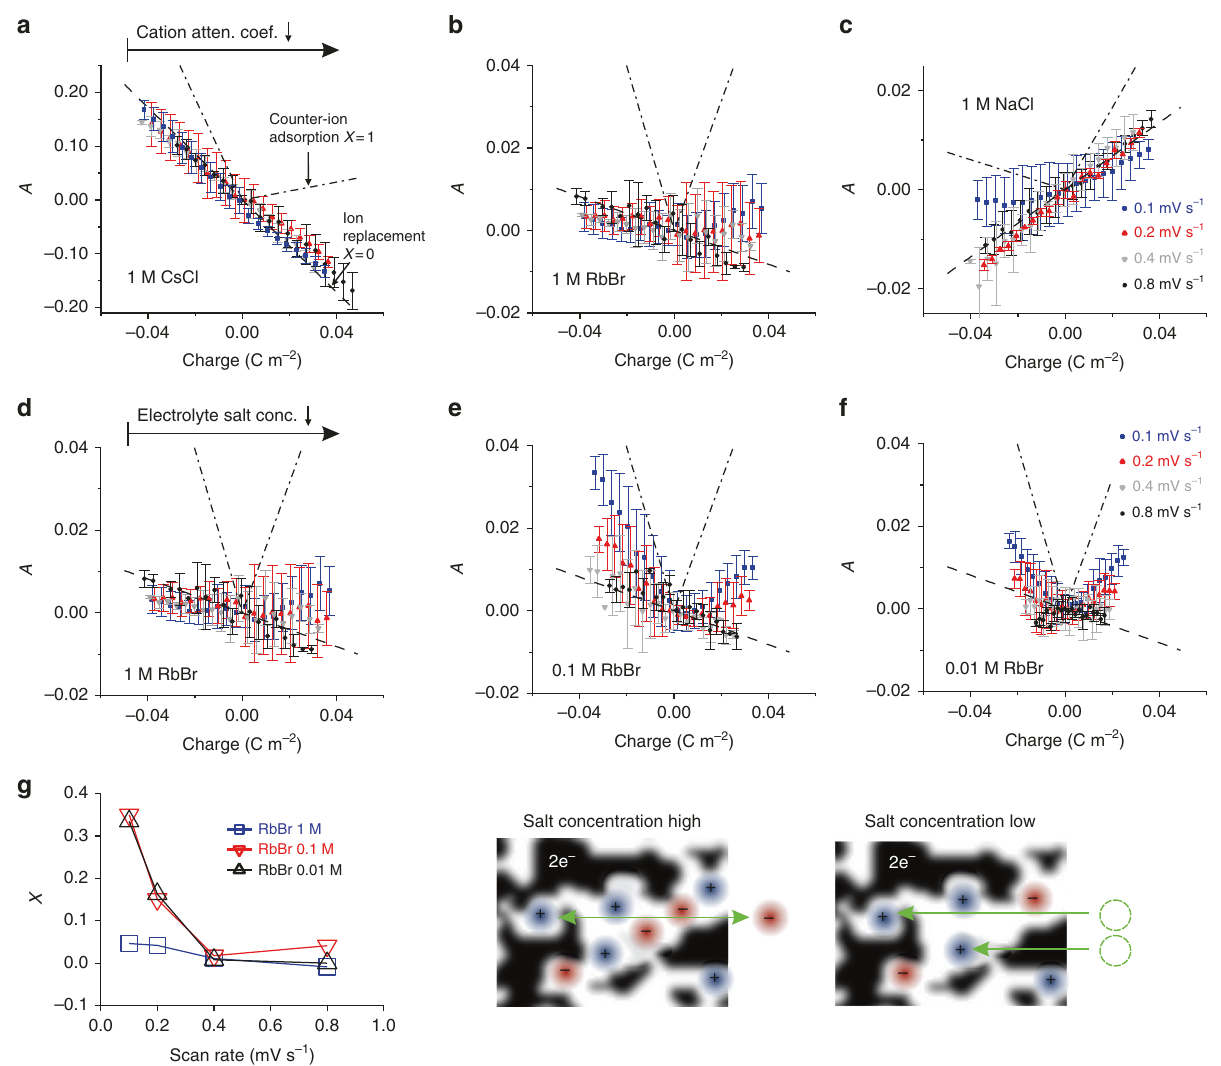
Fig. 2 Quanti fi cation of parameters controlling ion charge storage mechanisms. a – f Relative attenuation A (Eq. 2) vs. electrode charge for in situ cells using different aqueous electrolytes at four different scan rates with ±0.5 V maximum applied cell voltage. In a – c , the attenuation coef fi cient of cations (Table 1) becomes smaller from left to right, whereas in d – f , the salt concentration was decreased from left to right. The black lines indicate the theoretical attenuation curves for pure ion swapping (dashed) and counter-ion adsorption (dashed dotted) calculated from Eq. 2. Note the different scales in a – c . The charge storage mechanism is quanti fi ed in g plotting the charge storage parameter X (see Eq. 3) vs. the scan rate for RbBr. With decreasing salt concentration counter-ion adsorption becomes the dominant charge storage mechanism, as visualized in g on the